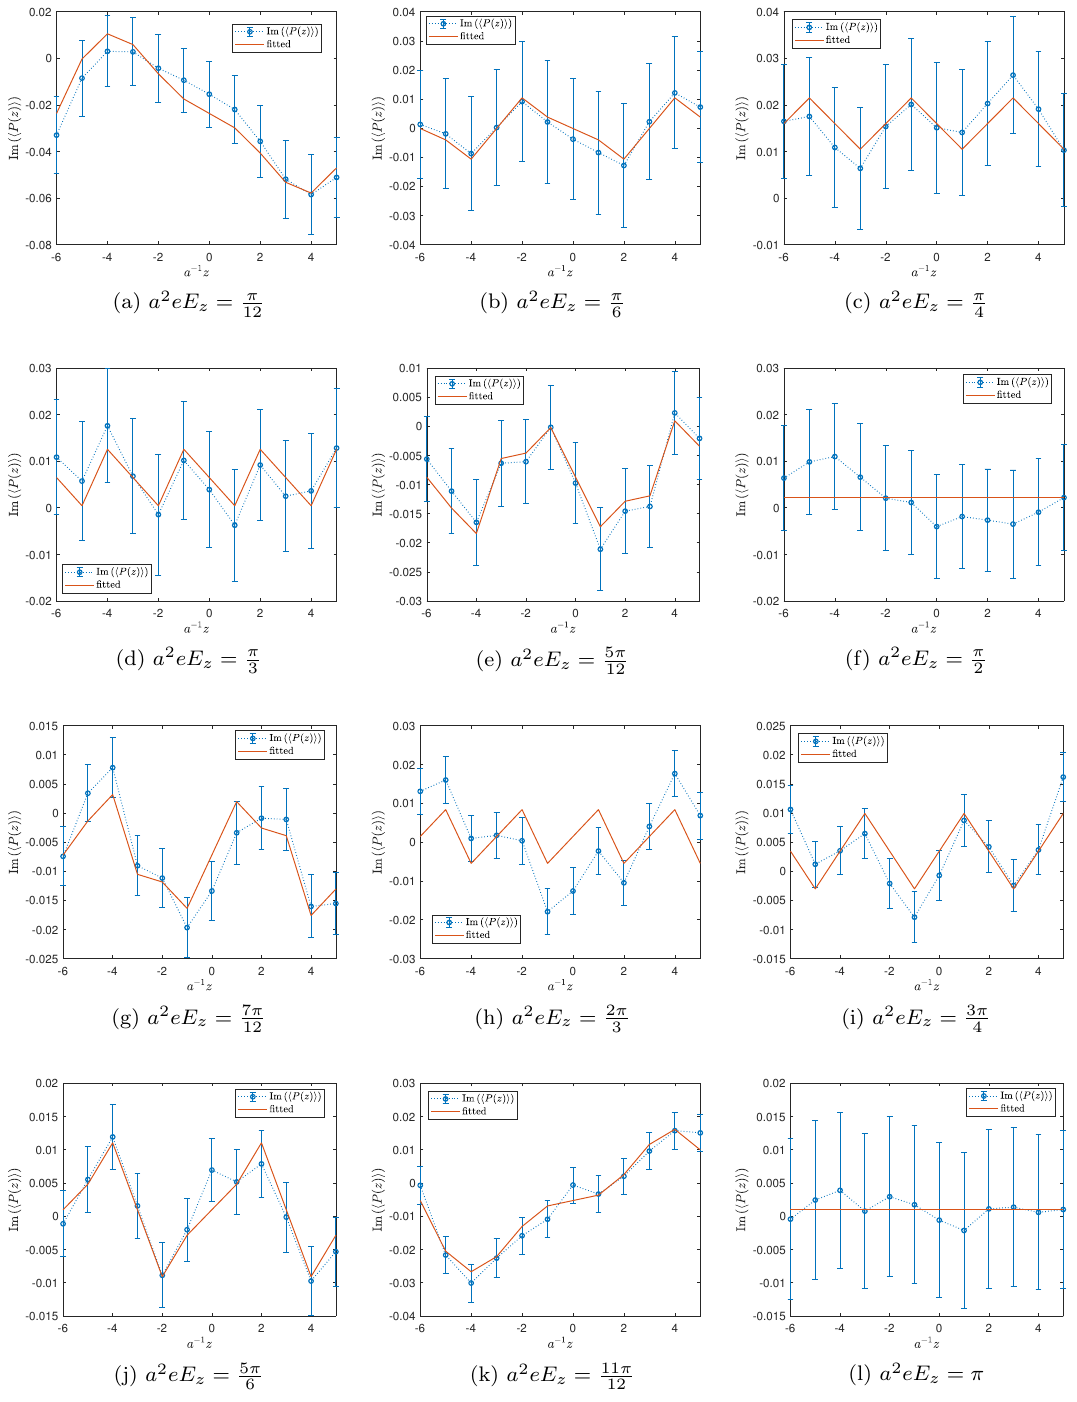
Figure 31 . Same as figure 6 but for Im ( h P ( z ) i ) at β = 5 . 42